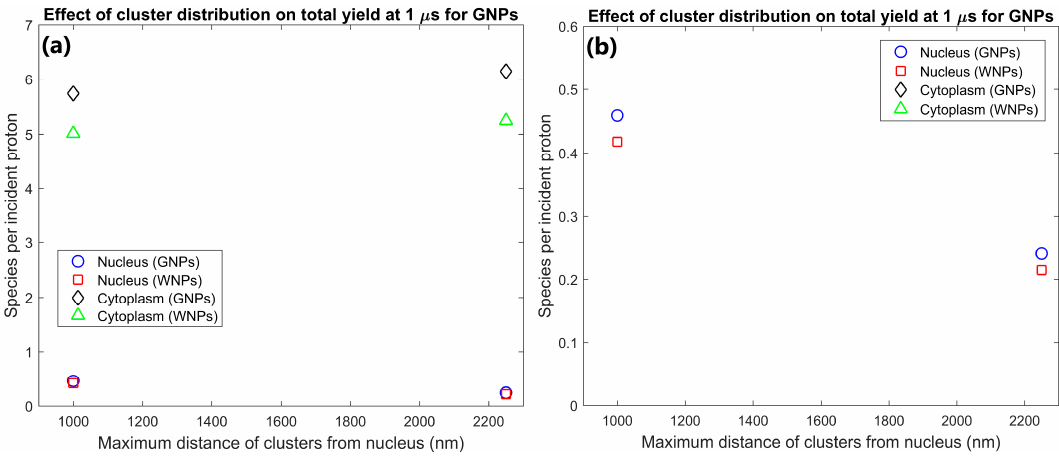
Figure 1. ( a ) Effect of proximity of GNP and WNP cluster distributions to the nucleus on reactive species yield at 1 µs from secondary electrons for cells with 1000 clusters of 200 nm diameter within the cytoplasm. ( b ) Highlight of nucleus yields shown in (a).